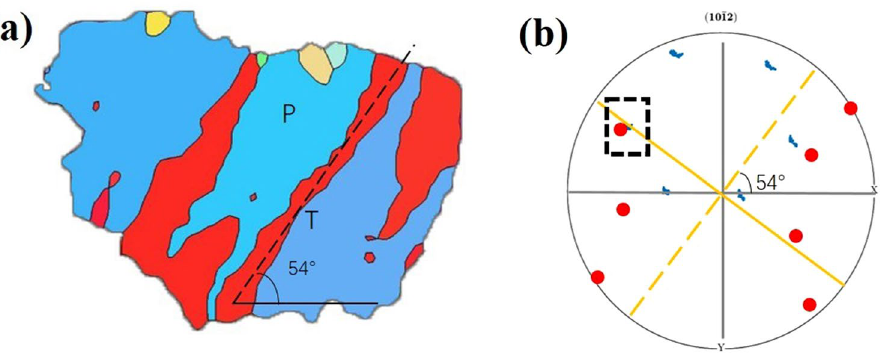
Figure 10. Inverse pole figure of the local EBSD twins of the specimen after ultra-low temperature rolling ( a ); {10 1 2} pole figures of the parent grain (P) and twin (T) ( b